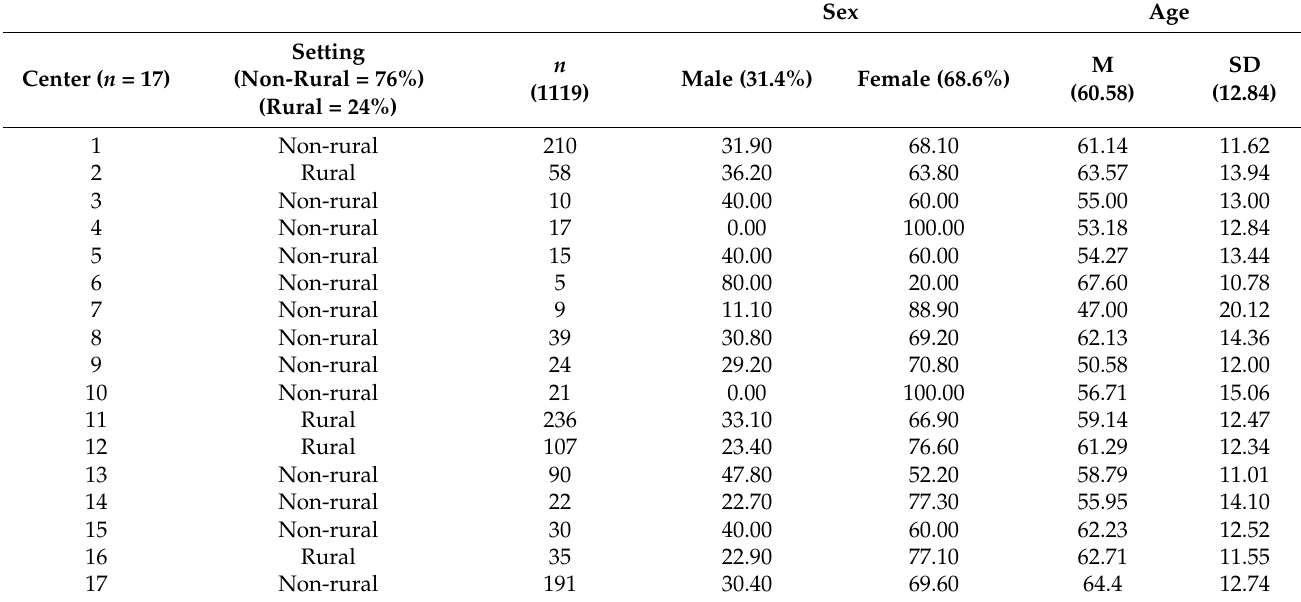
Table 1. Sample Characteristics by Center.